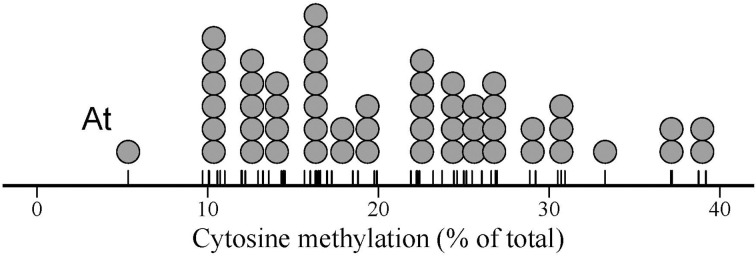
Dot plot of global DNA cytosine methylation in the sample of 54 angiosperm species studied. Each dot represents one species, and dot width corresponds to the maximum bin width as determined from the data using a dot-density binning algorithm. The position of data points on the axis are denoted by tick marks. “At” indicates the position of Arabidopsis thaliana, discussed in the text.